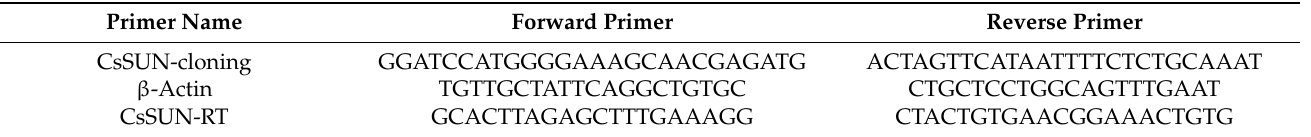
Table 1. Primers used in this